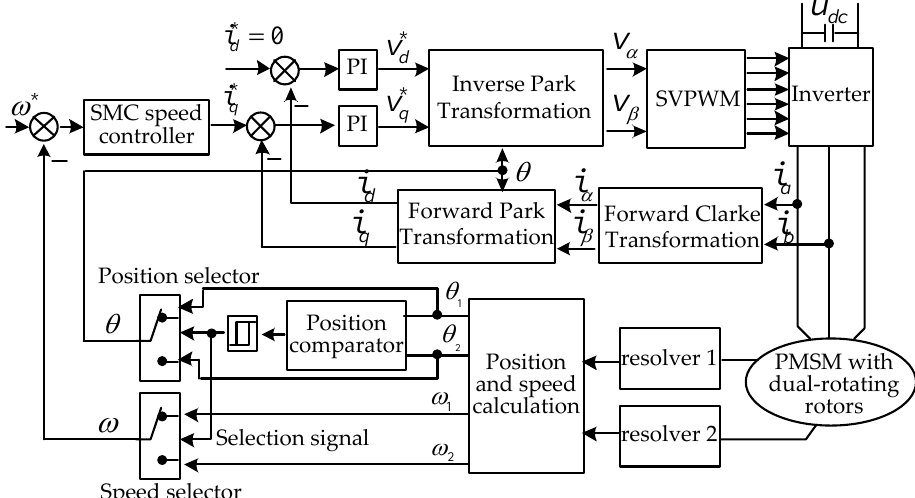
Figure 4. Overall block diagram for the proposed speed control scheme. Table 1. Nominal parameters of the permanent magnet synchronous motor (PMSM) with dual-rotating rotors.